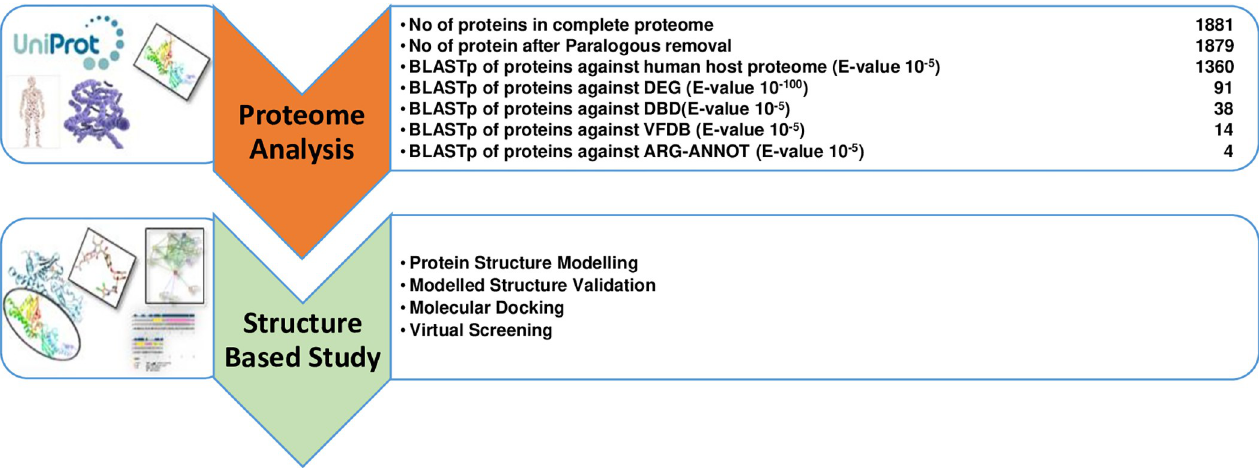
III) ERRAT Validation of Proteins The ERRAT tool was used to validate the unbounded statistics between two atoms confor- mation in the structure. It resulted in the quality factor of about 89.147% as shown in S3 Fig. IV) PROSA web Validation of Proteins The ProSa web server tool was used to calculate the quality of the 3-D structures of proteins in terms of Z-score in the structure of modelled protein. The resulted Z-score is -7.33. The Z-score was calculated using NMR Spectroscopy (dark blue) and X-ray crystallography